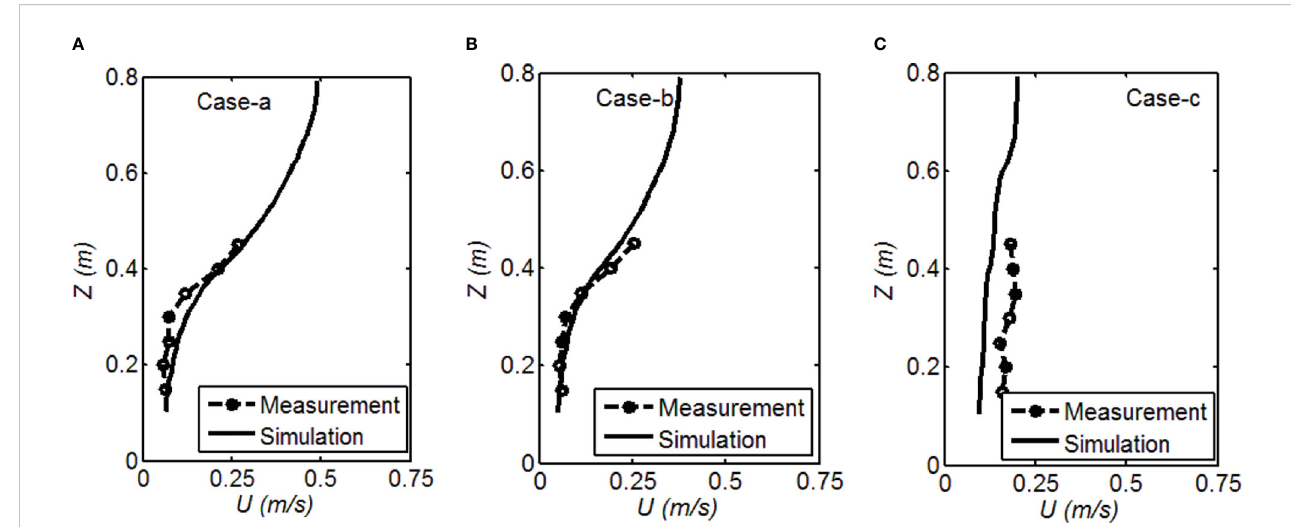
FIGURE 2 Comparisons of measured and simulated mean velocities in Test 1: (A) Case-a, (B) Case-b, (C)